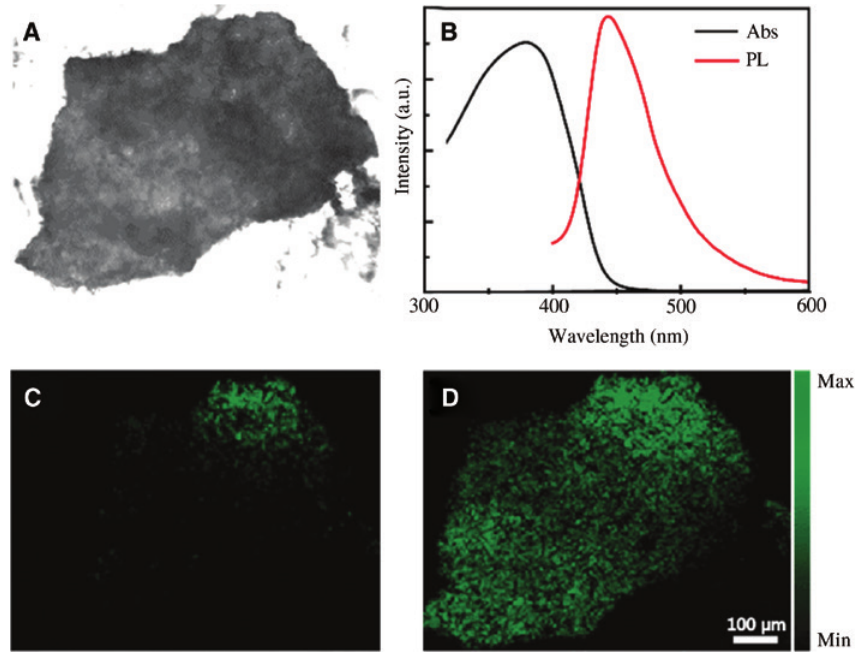
N . 3 4 N . (B) The absorption and PL spectra of g-C 3 4